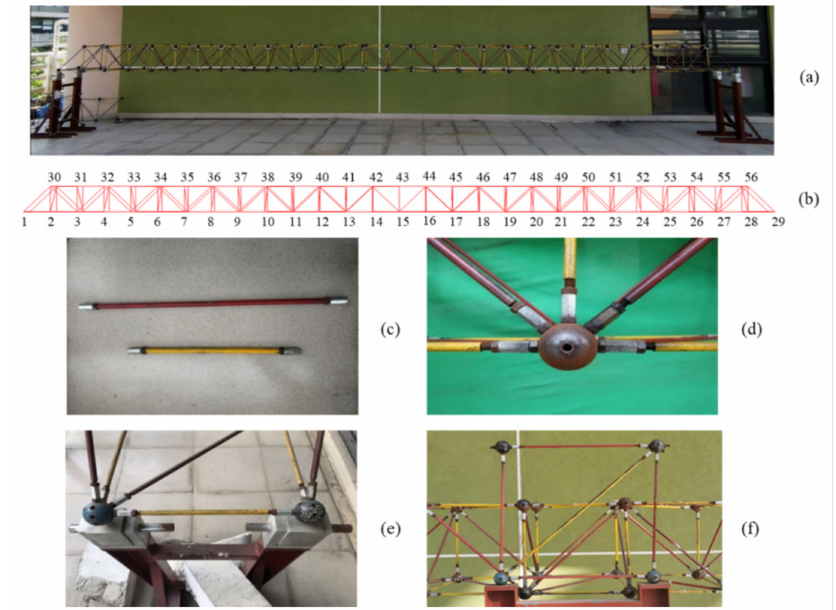
Figure 4. Experimental model: ( a ) Overall model; ( b ) Model node number; ( c ) Rods; ( d ) Component connection; ( e ) Supports; ( f ) Rectangular correction frame.